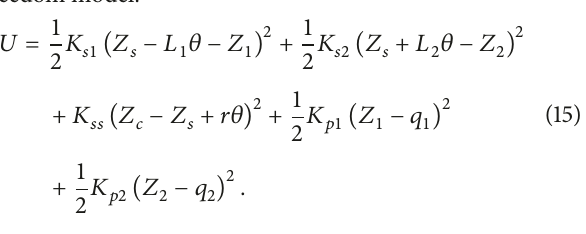
front tire velocity, rear tire velocity, relative displacement between sprung mass and front tire, and relative displacement between sprung mass and rear tire, for a five-degree-of- freedom (five-DOF) vehicle vibration